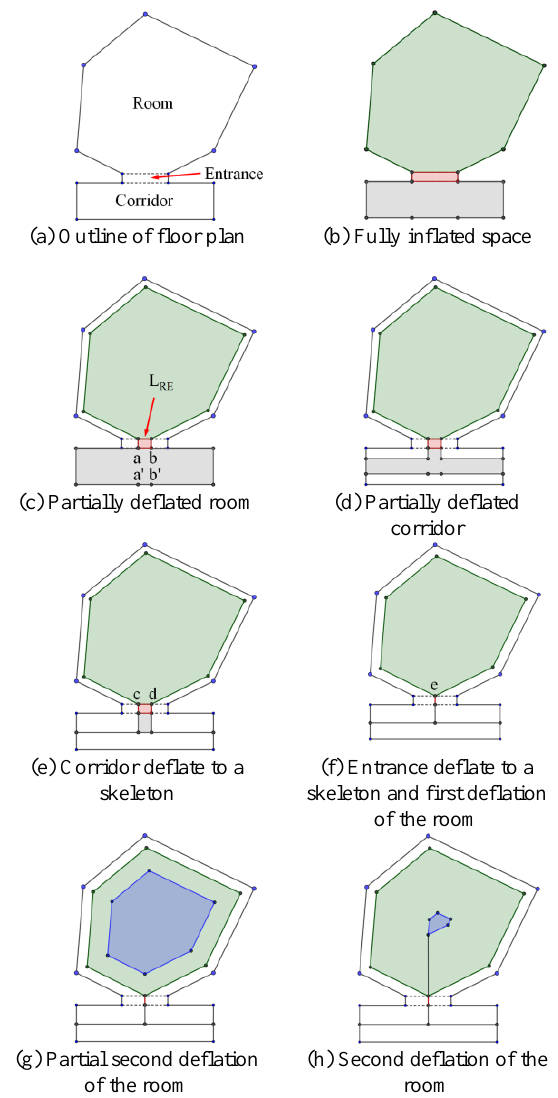
Figure 2. A simple floor map showing one room, an entrance and a corridor. The floor plan is stored and represented as a closed polyline. Steps (a) to (g) show the variations in the deflation of the floor plan. Notably the room and corridor don’t have to be deflated to the same